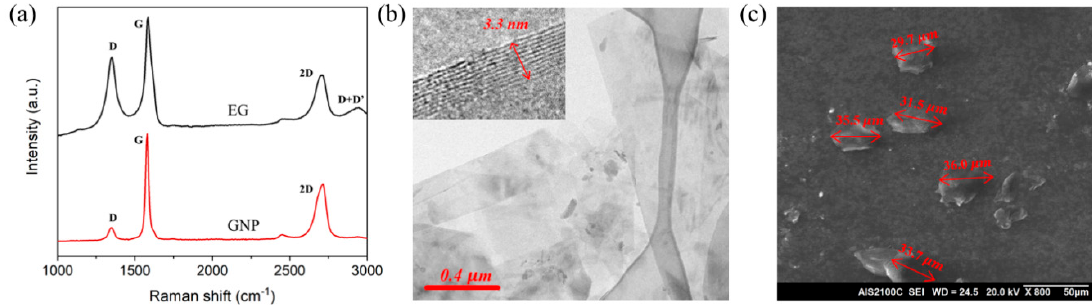
Figure 1. Raman spectra ( a ), HR-TEM image ( b ), and SEM image ( c ) of the graphene nanoplates (GNPs).